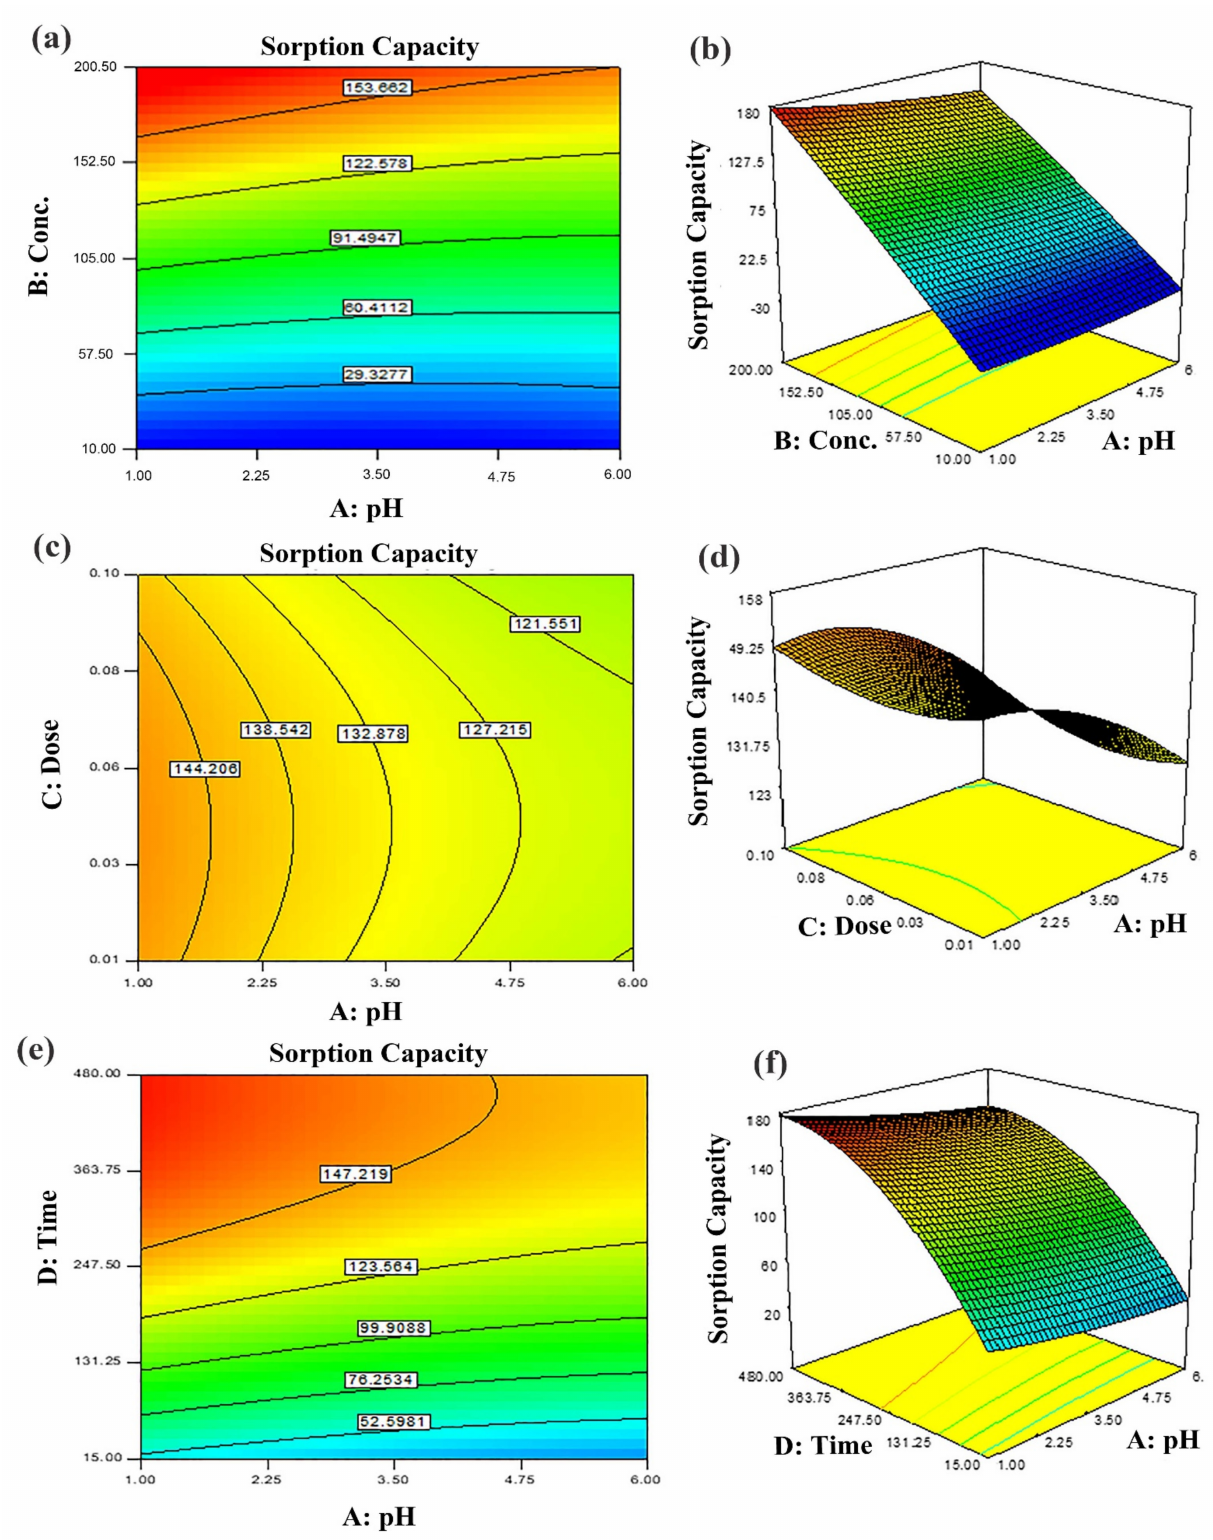
Figure 6. Predicted dye removal contour plots under influence of: ( a ) pH–initial concentration, ( b ) pH–sorbent dose, ( c ) contact time–pH and the related response surface plots in ( d – f ) at central point values of other